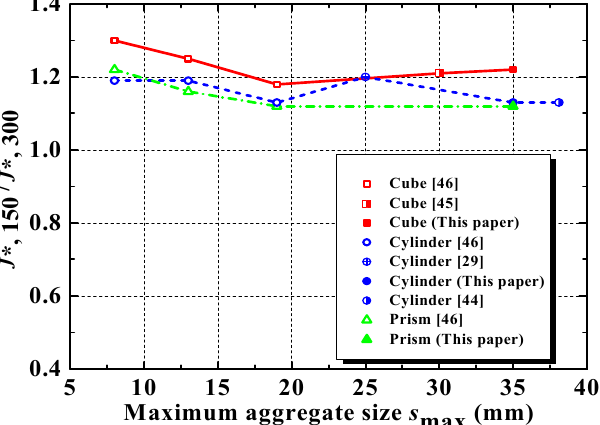
Figure 7. Variation of f *,150 / f *,300 with maximum aggregate size s max .